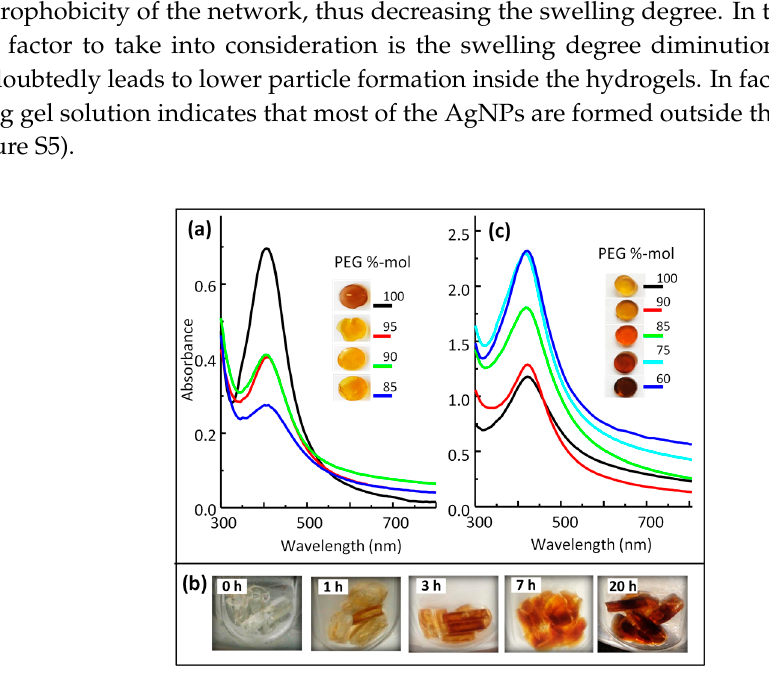
Figure 2. UV-Vis spectra of ( a ) Ag–PSA and ( c ) Ag–PU hydrogel nanocomposite disks for several